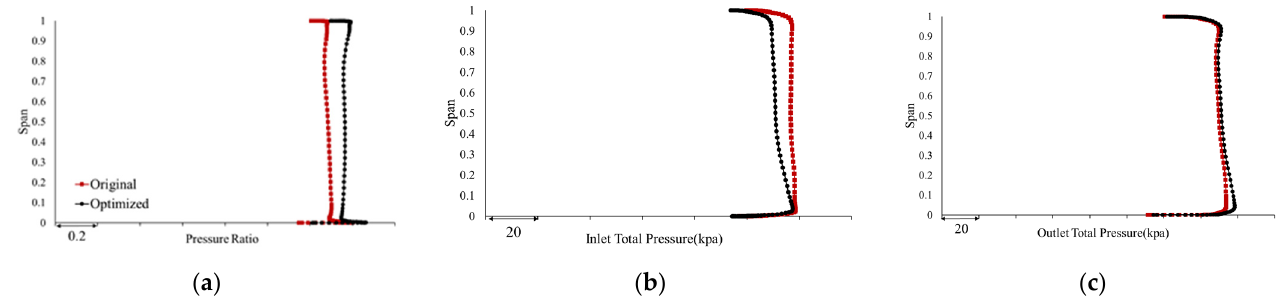
Figure 15. Pressure spanwise distribution of R1. ( a ) Pressure ratio; ( b ) inlet total pressure; ( c ) outlet total pressure.